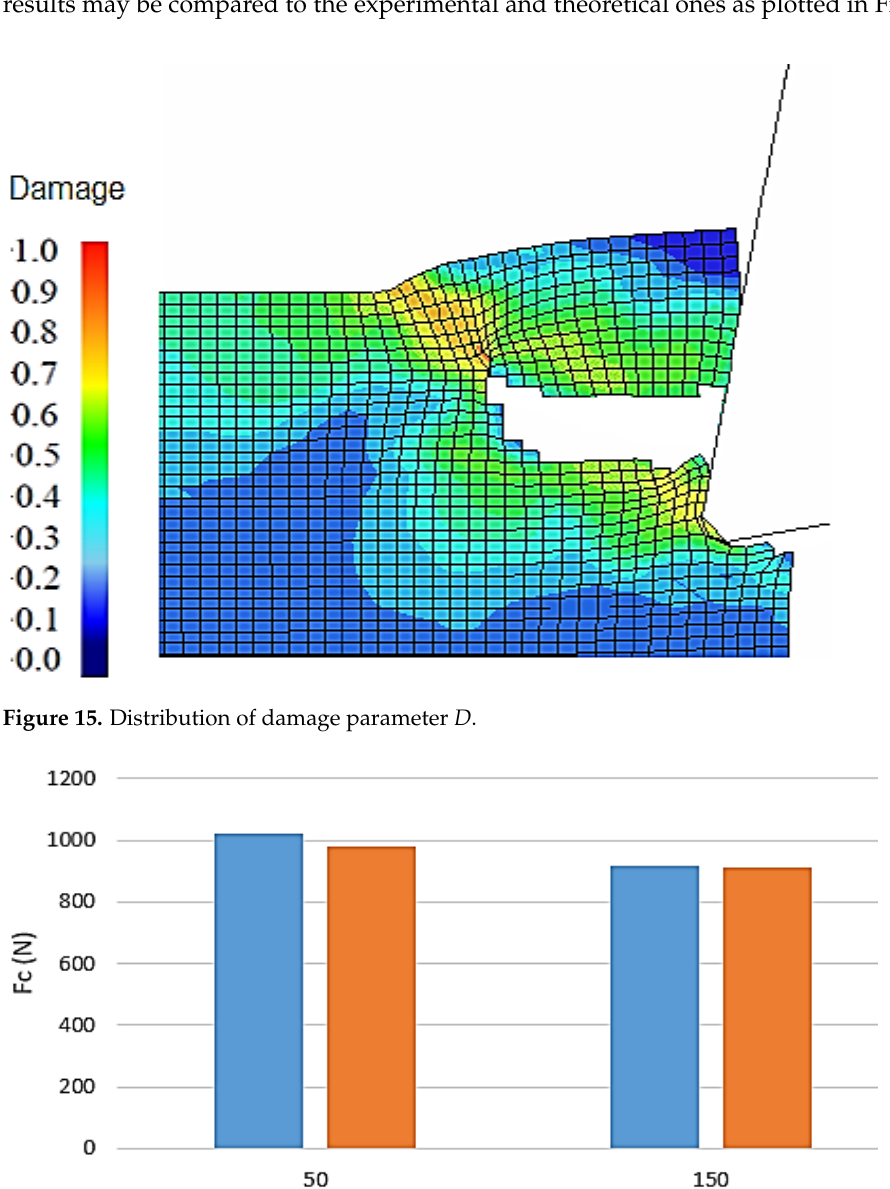
Figure 15. Distribution of damage parameter D.